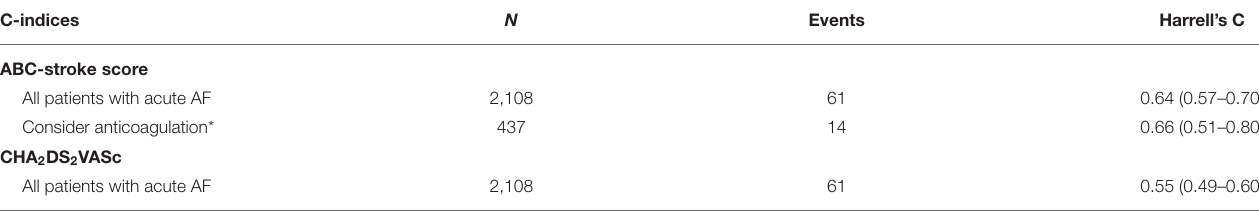
TABLE 3 | C-indices for the ABC-stroke and CHA 2 DS 2 -VASc scores.